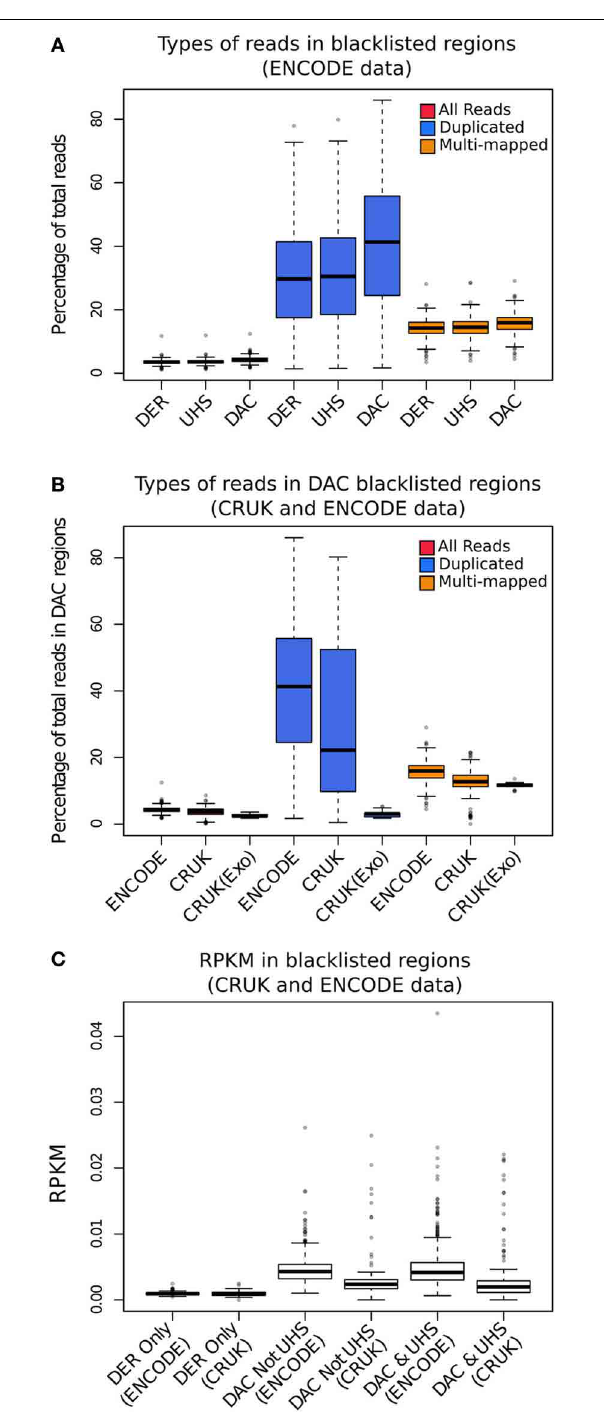
FIGURE 2 | (A) The boxplots show the percentage of total reads for all (red), duplicated (blue), and multi-mapped reads (orange) within the DAC consensus, UHS, and DER blacklists for ENCODE/SYDH datasets. (B) The boxplots show the percentage of total reads for all (red), duplicated (blue), and multi-mapped reads (orange) within the DAC consensus for ENCODE/SYDH and CRUK datasets. (C) Boxplots illustrating the range of RPKM within blacklist classes for DER only, DAC consensus not within UHS and the overlapping DAC consensus and UHS regions.